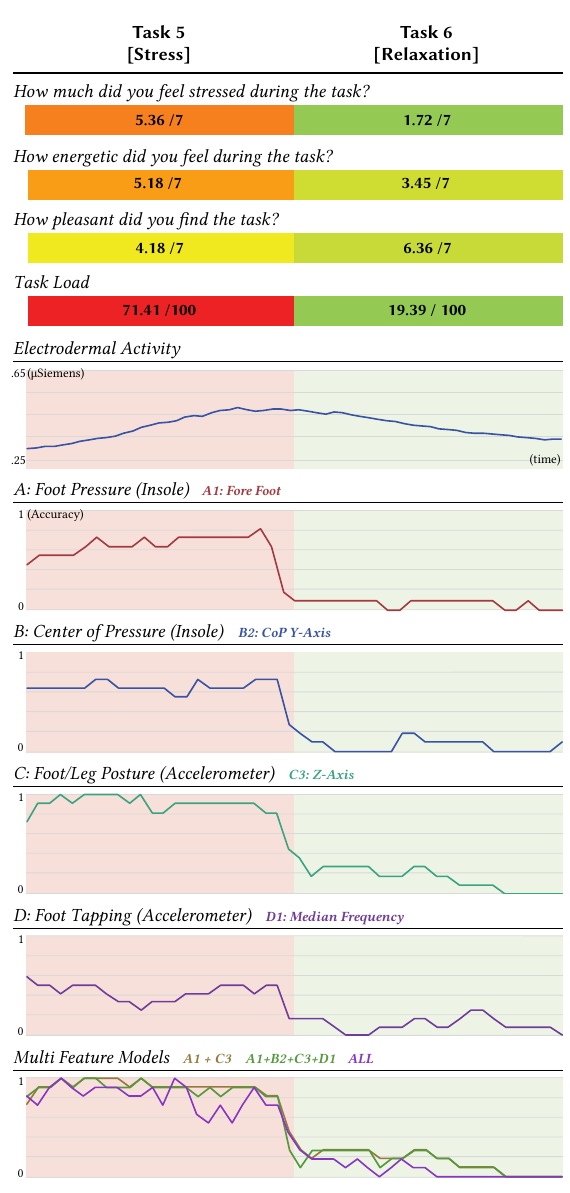
Figure 6. Results of generalisability. The graph of electrodermal activity and accuracy shows the averages of the 11 participants over non-overlapping windows of 10